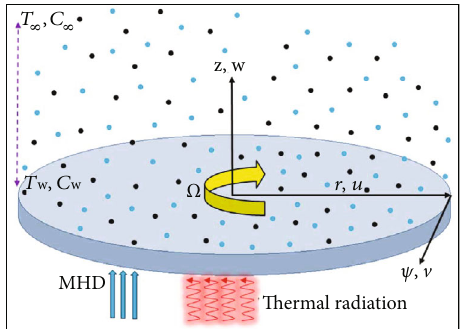
Figure 1: Pictorial sketch of the spinning fl ow.